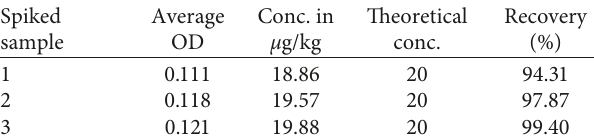
Table 1: Spiked samples with aflatoxin standard at 20 μ g/kg.